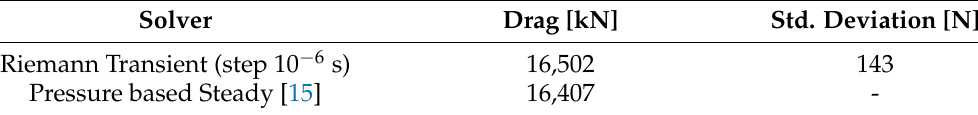
Table 3. Different solvers used.